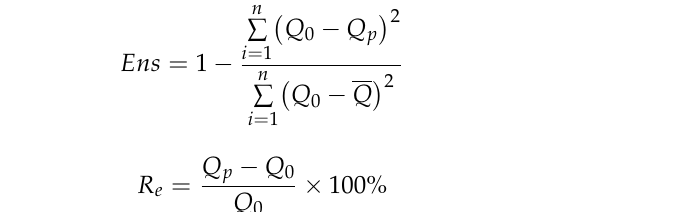
Table 2. Parameter values of black soil test model.